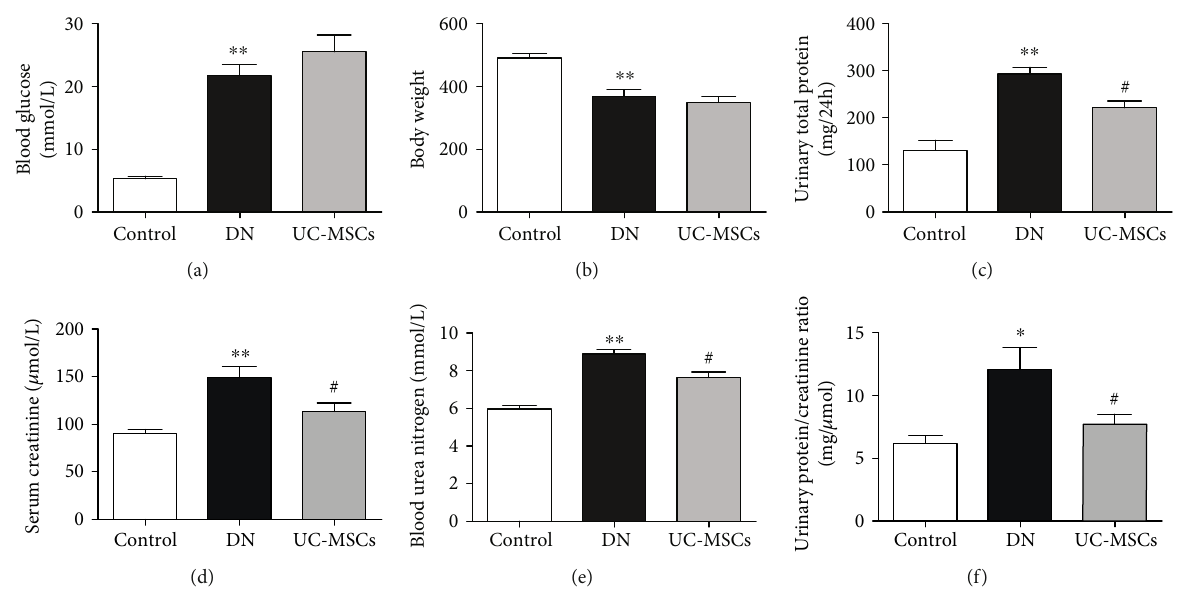
Figure 2: Physical and biochemical analysis of rats. The diabetic model was established by increased blood glucose (a) and reduced body weight (b). Renal function of rats was assessed by 24-hour urinary total protein (c), serum creatinine (d), blood urea nitrogen (e), and urinary protein/creatinine ratio (f) ( n = 4~5 , ∗ p < 0 : 05 versus control group, ∗∗ p < 0 : 01 versus control group, and # p < 0 : 05 versus DN